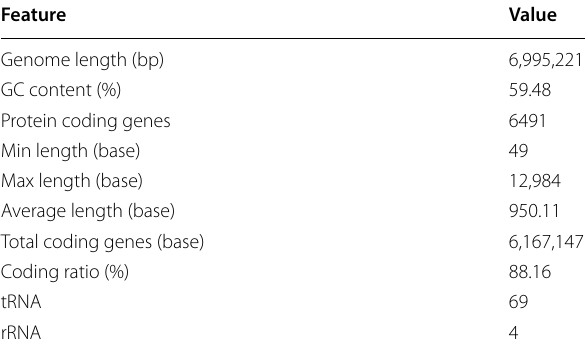
Table 2 Genomic features of Pseudomonas